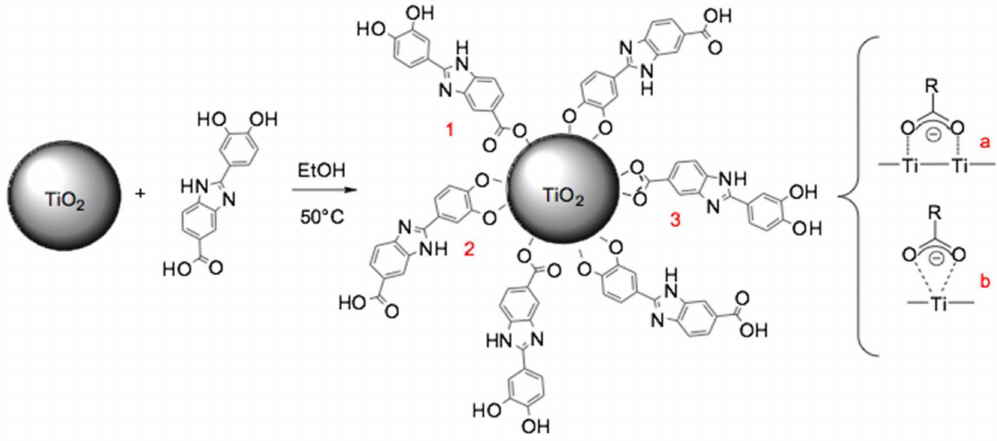
Figure 5. Addition mechanism of Oxisol to TiO 2 particles. As proved by FT-IR analysis option 1 and 2